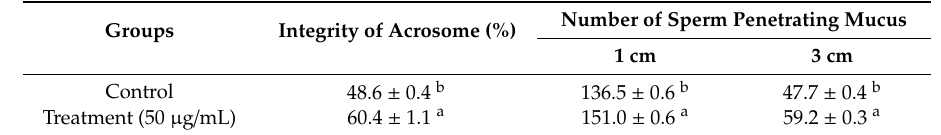
Table 4. E ff ects of exosomal protein treatment on acrosome integrity and mucus penetration ability of post-thaw dog semen.